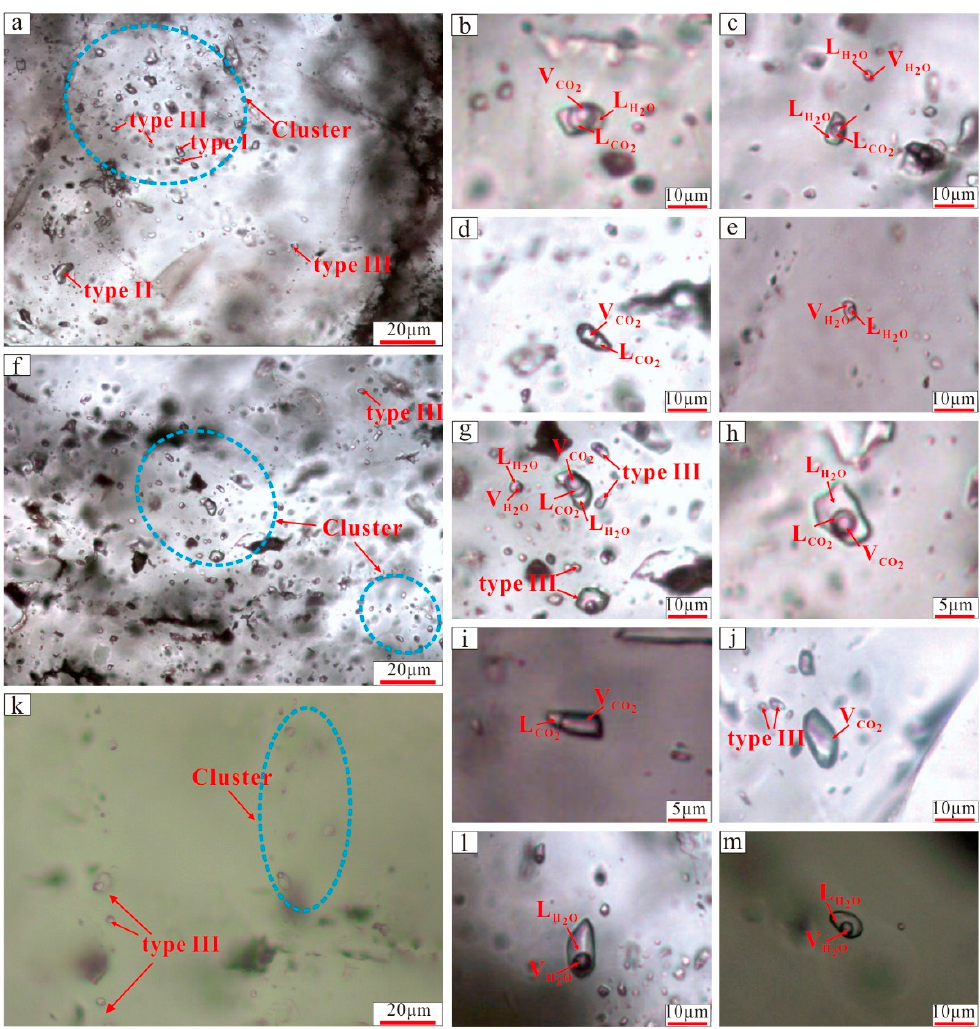
Figure 8. Photomicrographs of various types of fluid inclusions in the Liyuan gold deposit. ( a ) Coexistence of different fluid inclusions as clusters or isolated in the early stage; ( b ) typical